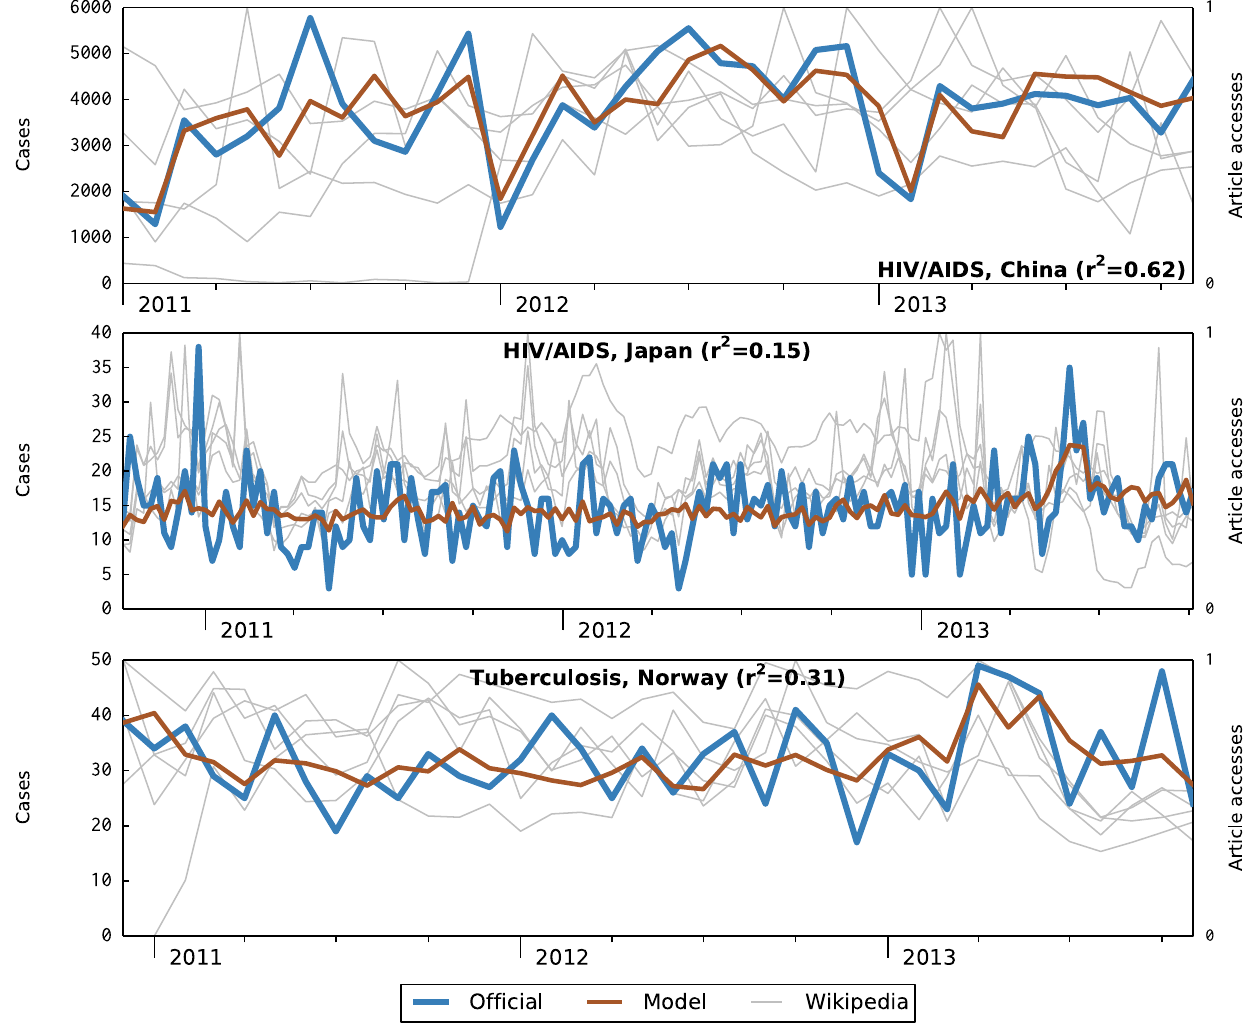
Figure 3. Nowcast attempts where the model was unable to capture a meaningful pattern in official data.